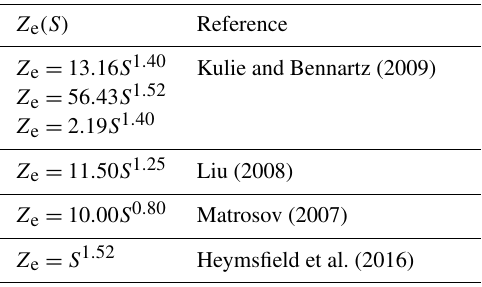
Table A1. The snowfall retrieval relations used in calculating the example profile in Fig.